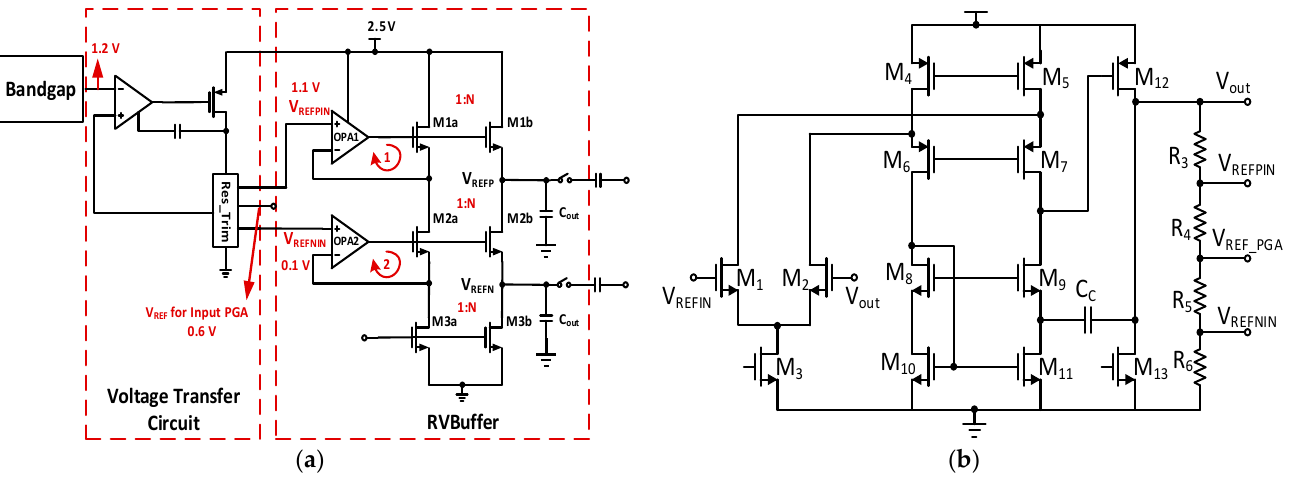
Figure 9. ( a ) The structure of the proposed RV-Buffer; ( b ) the structure of the voltage transfer circuit.